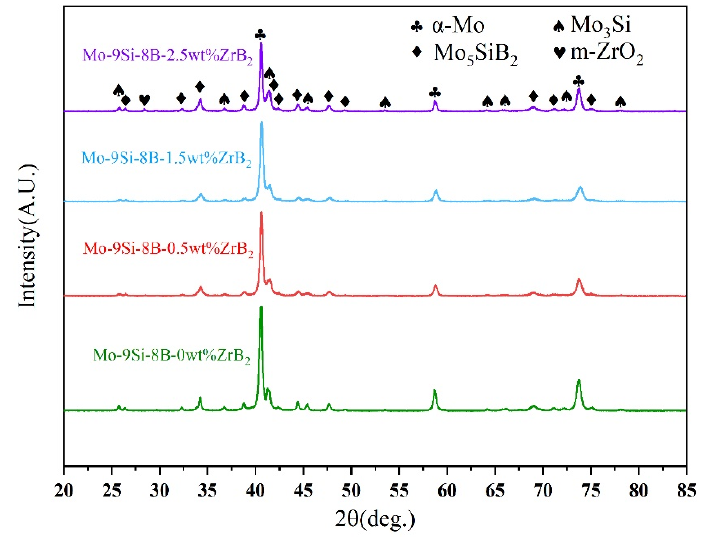
Figure 2. XRD diffraction patterns for alloys with different Zr